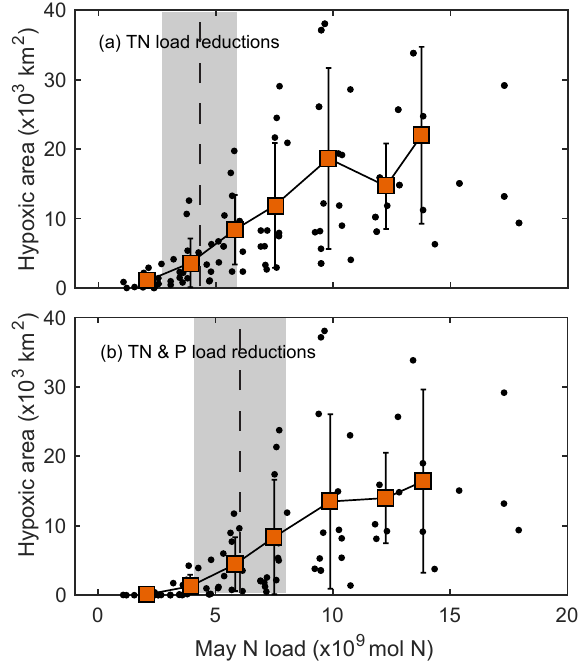
Figure 6. Simulated midsummer hypoxic area plotted over May N load for nutrient load reduction scenarios. (a) Simulated hy- poxic area for current loads and all simulations with reduced N loads (black dots), binned means ± 1 SD (orange squares with error bars) and value at which target of 5000km 2 hypoxic area would be reached ± 1 SD (dashed line and gray shade). (b) Same as middle panel but for proportional reductions of TN and P